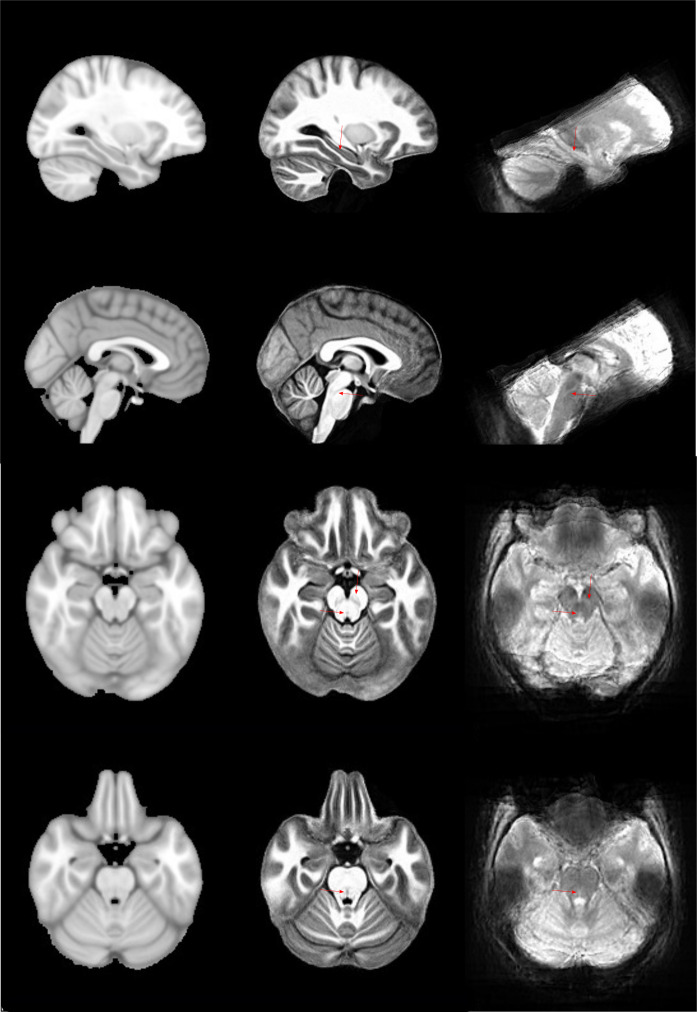
Sagittal and axial slices of the T1-weighted and fMRI average in the MNI space at the level of the hippocampus and brainstem.Note: The first column shows the matched MNI template. The middle column shows the average of individual T1-weighted scans warped to the MNI space. The right column shows the average of the individual fMRI scans warped to the MNI space. Note that for both averages relevant features such as the dentate gyrus, the substantia nigra and much of the internal structure of the brainstem (of a similar size to the locus coeruleus) can be clearly differentiated (red arrows), attesting to the quality of the registrations. See also the response letter to the reviewers for individual registration examples.